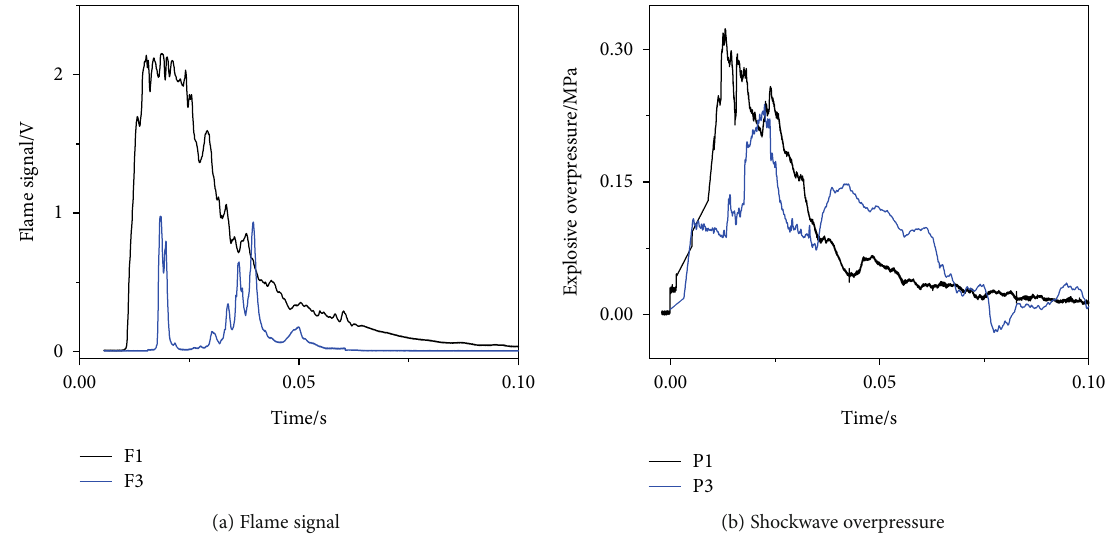
Figure 5: Explosion fl ame and shock wave